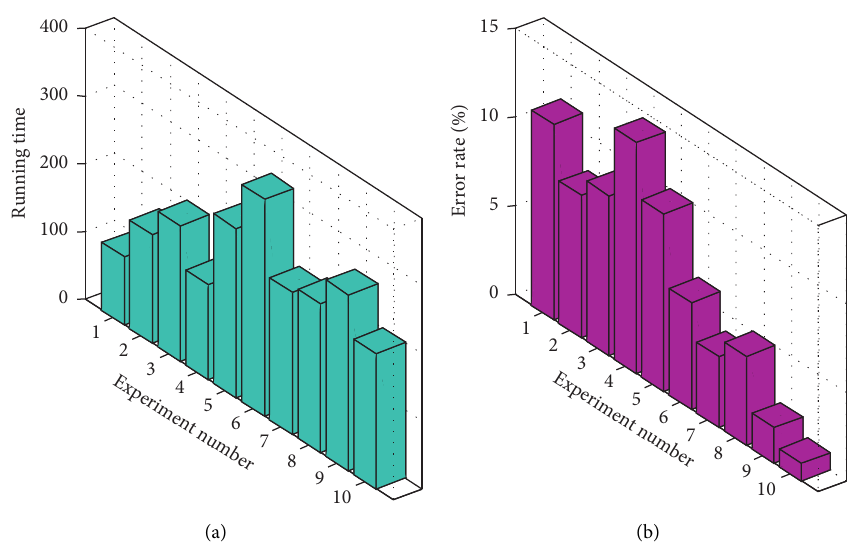
Figure 4: Test results of convolutional neural network on the data set. (a) Running time. (b) Error rate.